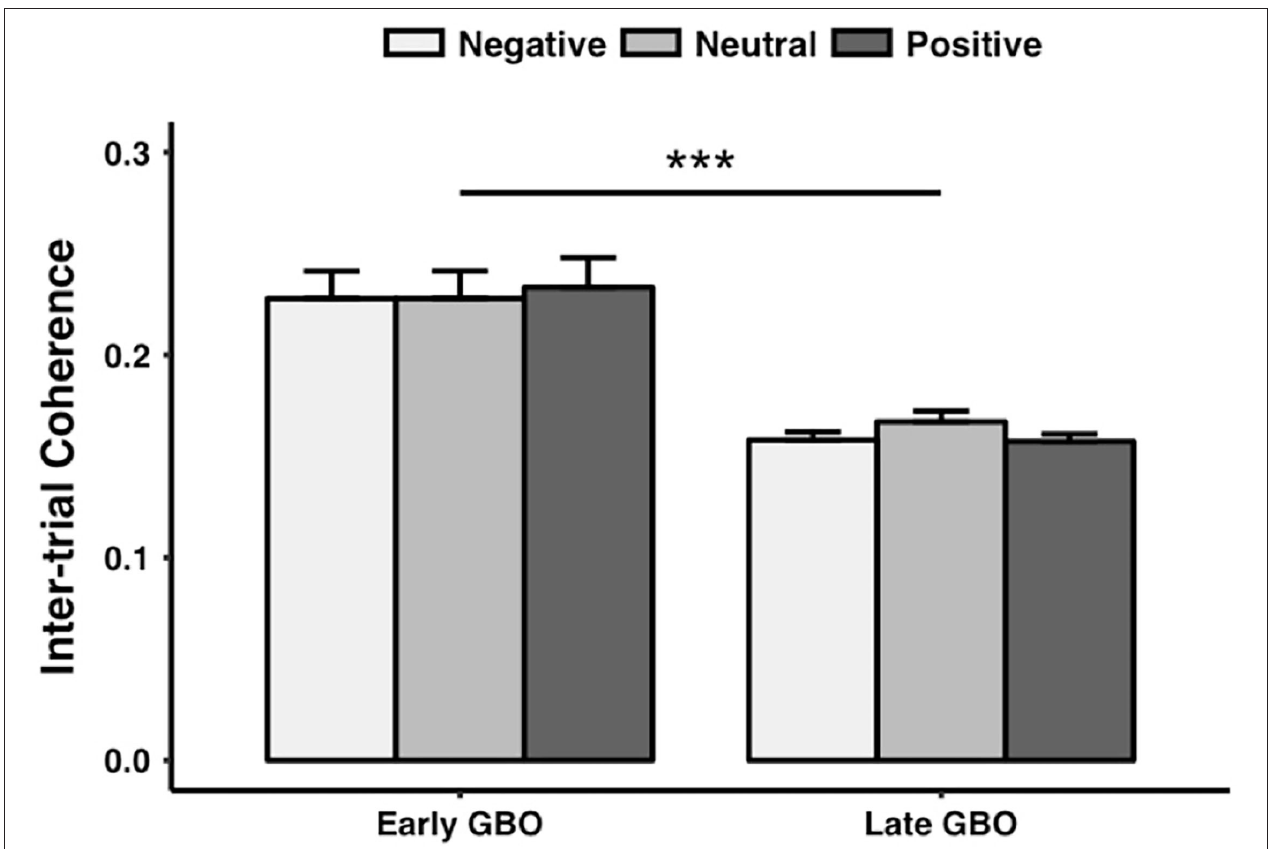
FIGURE 6 | The intertrial coherence of the early GBO was significantly larger than that of the late GBO. ***p <